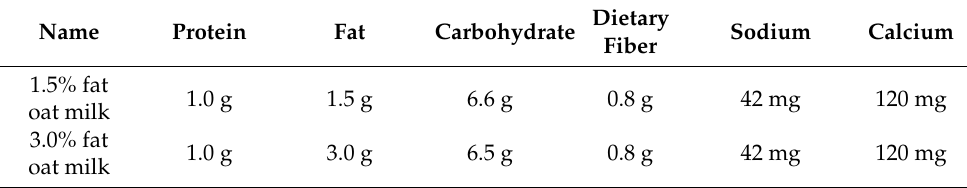
Table 1. Nutrition information per 100 mL of oat